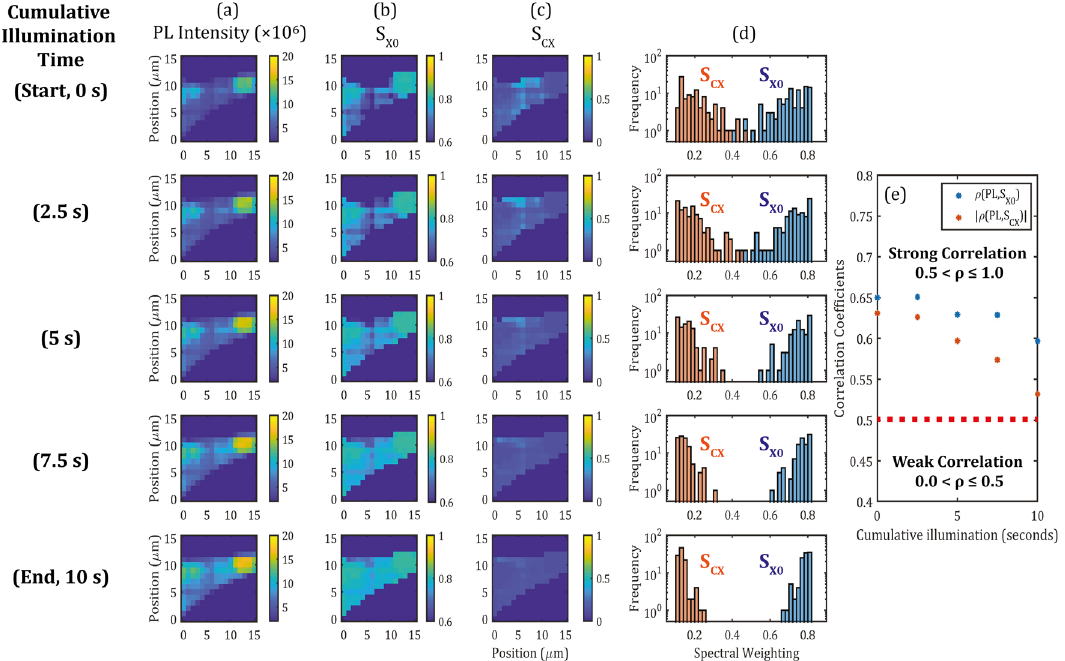
Figure 3. Illumination-time dependence for a small monolayer region studied using time-stepped PL maps. ( a ) Fitted PL intensity, ( b ) S X 0 and ( c ) S CX maps extracted at different laser illumination times. From top to bottom: t = 0 s (before laser illumination) and after repeated laser illumination time steps t = 2.5 s , 5 s , 7.5 s and 10 s . Histograms of S CX and S X 0 values from each map are plotted in column ( d ). Correlation statistics between the PL intensity and each of the spectral weighting maps S CX and S X 0 are extracted and plotted against the laser illumination time in ( e ), with the absolute value taken for ρ( PL , S CX )